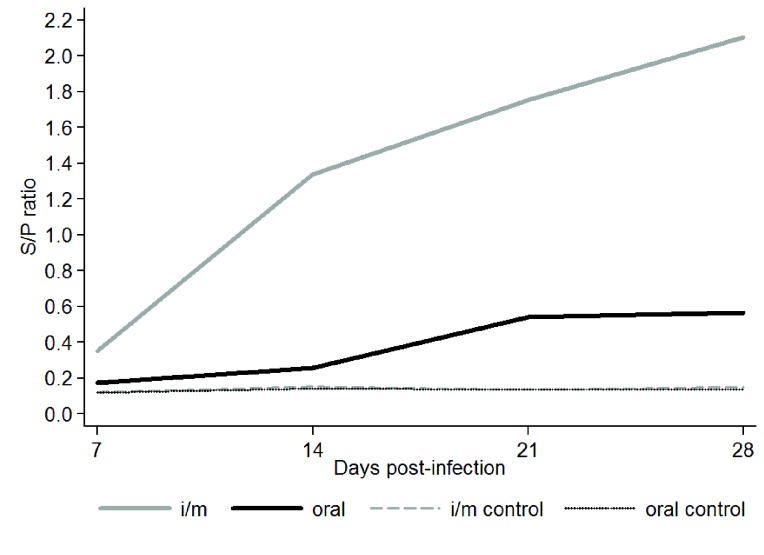
Antibody response to viral proteins in chickens inoculated with FAdV-4 by the oral and intramuscular routes and mock infected as measured by S/P ratios.Serum samples were collected at 7, 14, 21 and 28 days post-infection. Gray and black lines represent im and orally inoculated chickens, respectively. Dashed gray line and black dotted line represent mock-infected chickens. Statisticaly significant differences among mock infected and infected birds have been detected at 14, 21, and 28 d.p.i.